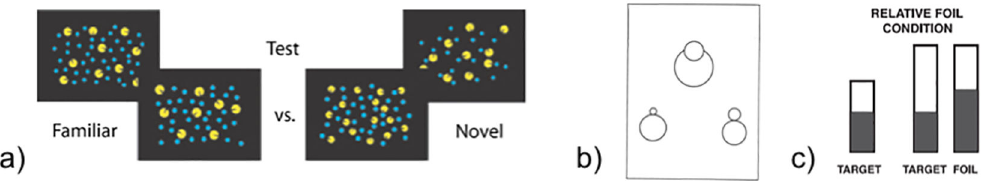
Figure 3. Nonsymbolic ratio stimuli used (a) with nonverbal infants by McCrink and Wynn, 2007, (b) with 4- and 5-year-old children by Sophian (2000), and (c) with 4-year-olds by Duffy, Huttenlocher, and Levine